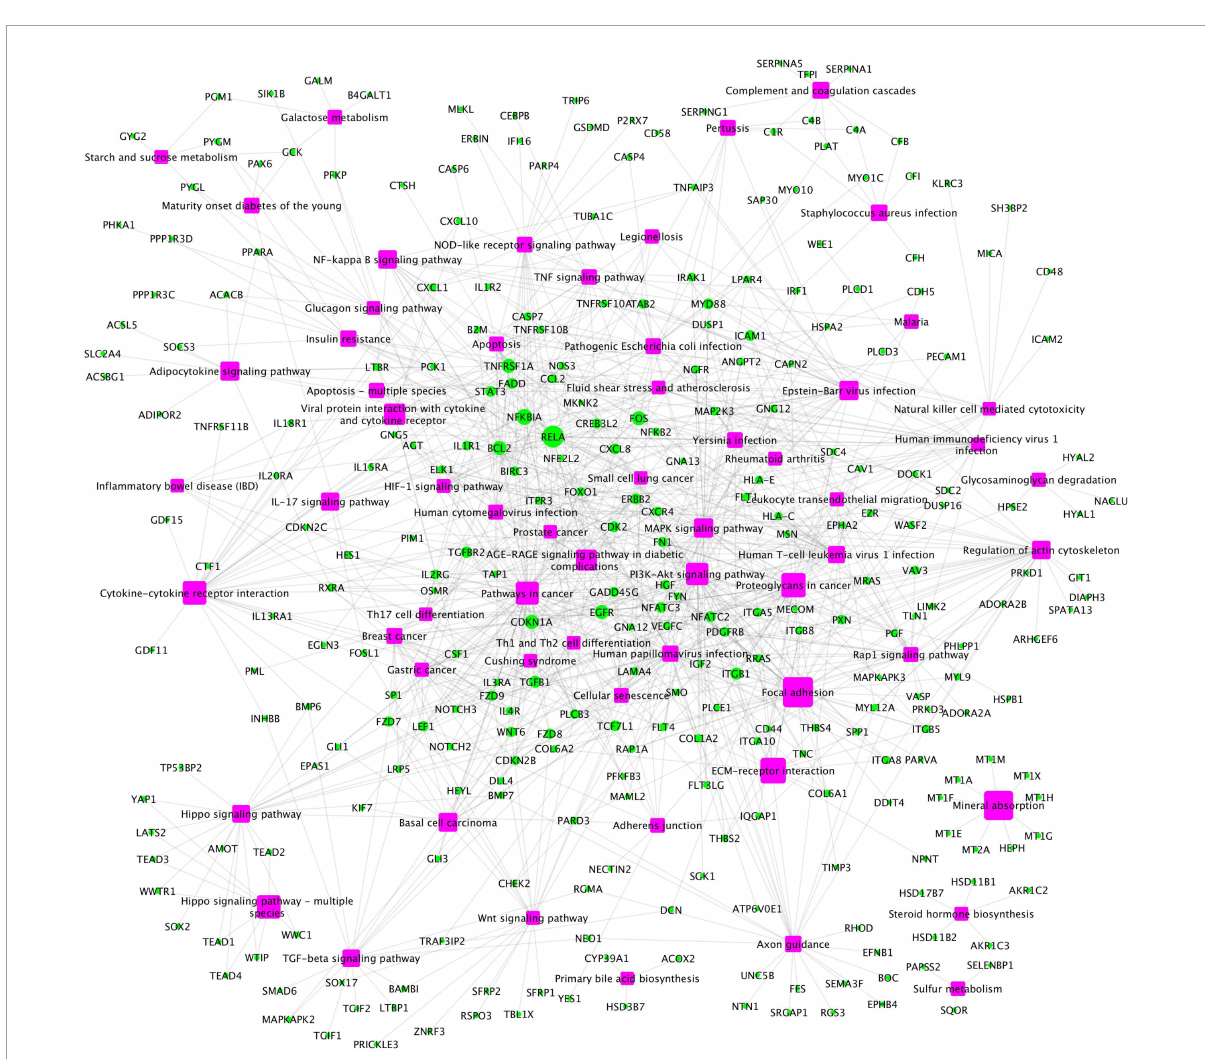
FIGURE4 The upregulated gene (green circles)-pathway (purpose squares) interaction network, including 1,021 interactions between 291 upregulated genes and 61 enriched